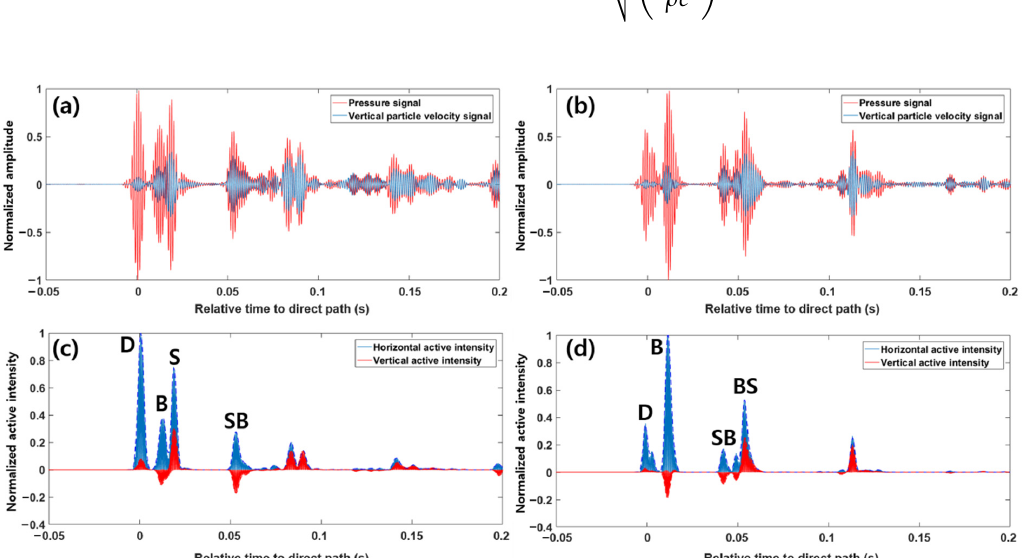
Figure 6. Bandpass-filtered pressure signals and estimated vertical particle velocities for source–receiver ranges of ( a ) 460 m and ( b ) 637 m; ( c,d ) show the estimated horizontal and vertical active intensities for the two ranges. The small peak between the D and B paths in ( d ) is the bubble pulse due to bubble oscillation, of which a detailed description is given later in this section. Figure 7a,b show the estimated results of beam-time migration (blue crosses) and the comparison with the best-fit beam-time migration curve (red dashed line) for source–re- ceiver ranges of 460 and 637 m, respectively. The best estimates of 𝜒 were − 3.21 and − 2.29 for 460 and 637 m source–receiver ranges, respectively. The horizontal ranges between the source and receiver were estimated to be 460.5 and 644.2 m for 460 and 637 m ranges with 𝛽 = 1.016 , which corresponded to range errors of 0.1% and 1.1%, respectively. Figure 7. Estimated beam-time migrations and the best-fit elliptic curve solutions estimated using the measurement and simulation data for source–receiver ranges of ( a ) 460 m and ( b ) 637 m. In this paper, because only the acoustic intensity of the vertical component was meas- ured and used for estimation of the source–receiver range, it is necessary to confirm the